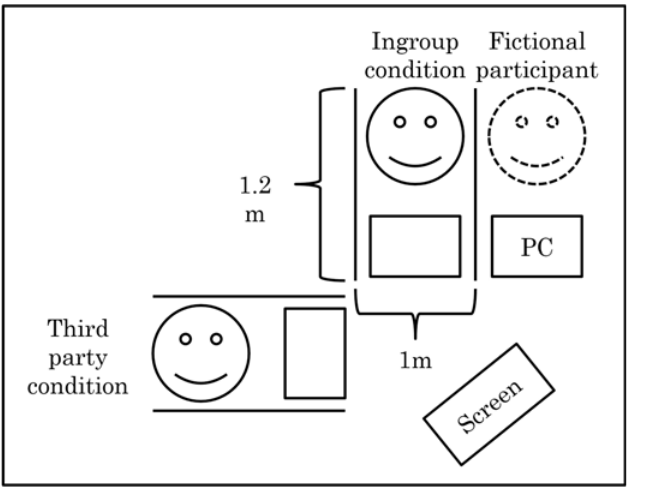
Fig 1. The layout of the laboratory